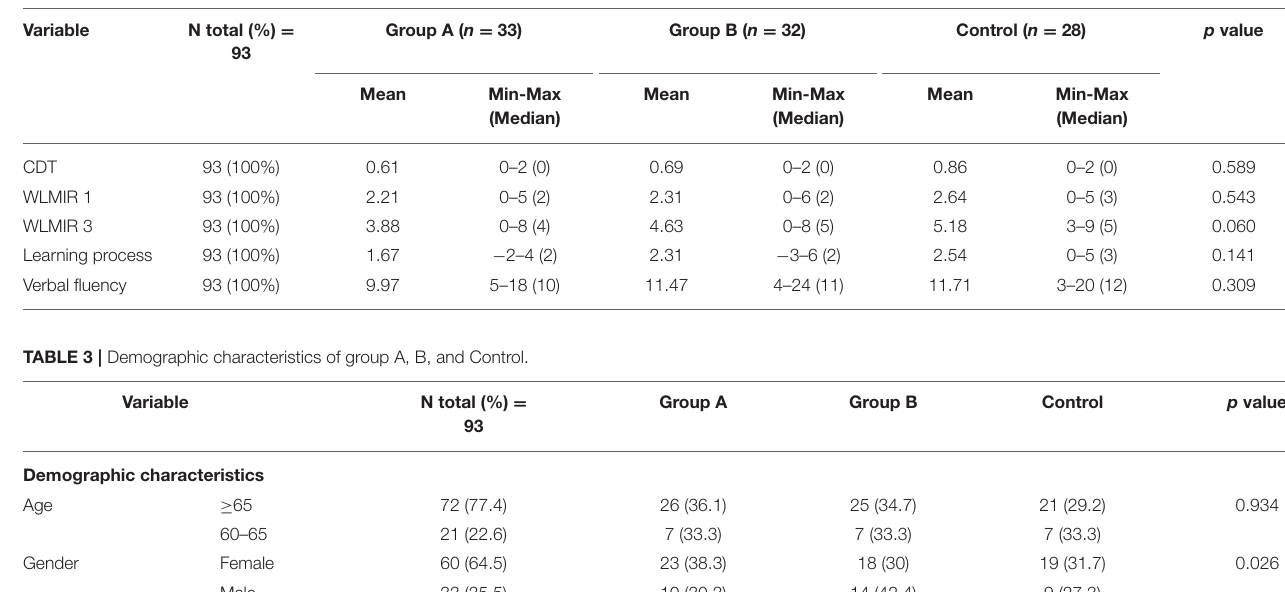
TABLE 2 | Baseline cognitive scores of group A, B, and Control.